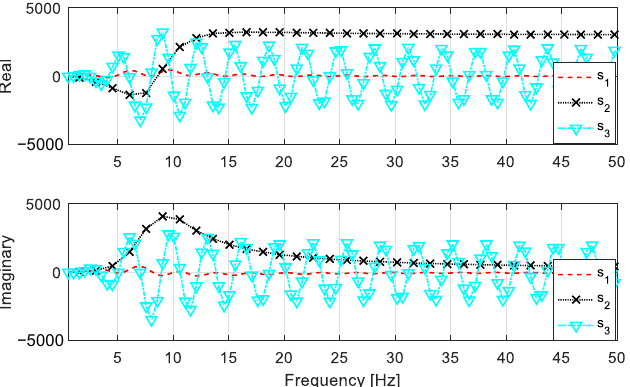
Figure 7. Real and imaginary parts of the acceleration frequency responses of the vehicle at the measurement points to the excitation applied successively on the rear wheel along DOF u 3 and the front wheel along DOF u 4 .